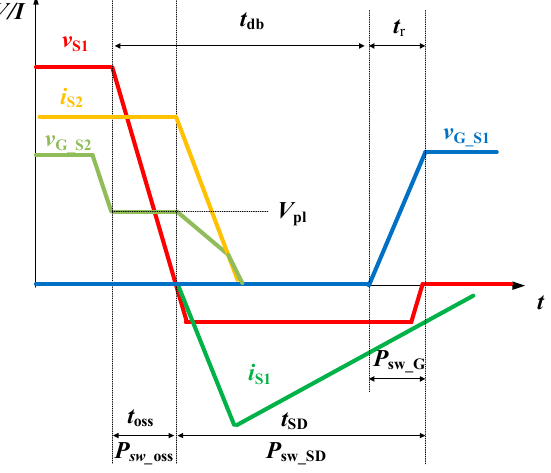
Figure 6. Current and voltage waveforms during the turn-on transition.